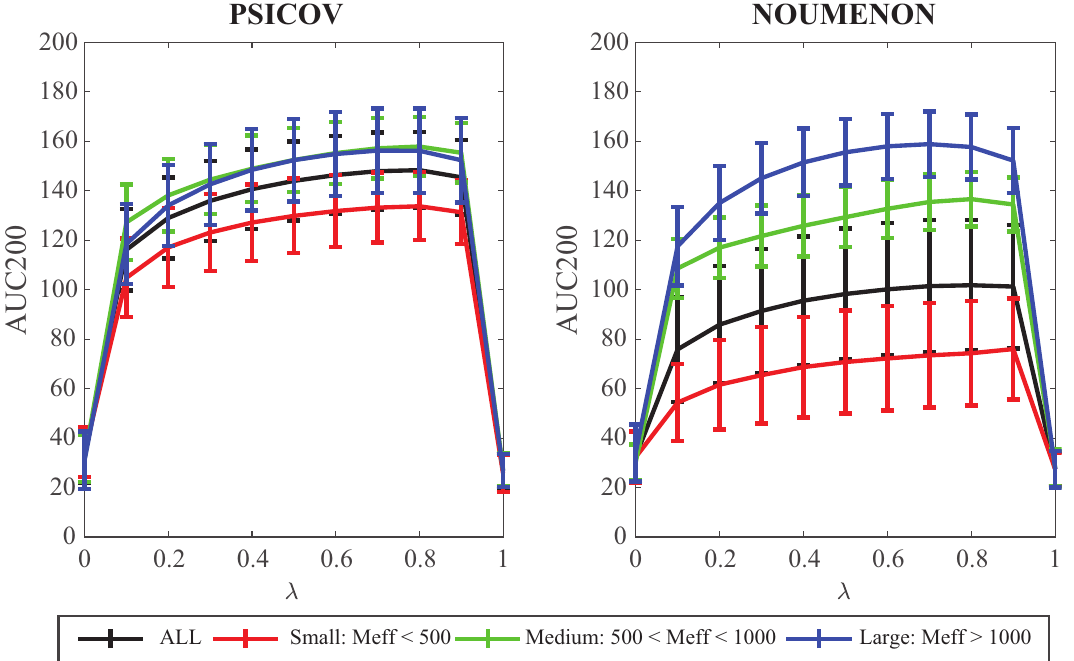
Figure 2. AUC200 plotted against λ , the weight of the prior in the Gaussian model for the PSICOV dataset ( left ) and the NOUMENON dataset ( right ). AUC200, with values between 0 and 200, is a measure of performance, with higher values indicating better performance. The 150 multiple sequence alignment (MSAs) in the datasets are broken down into 3 groups, small ( M ef f < 500, medium (500 ≤ M ef f < 1000), and large (1000 ≤ M ef f